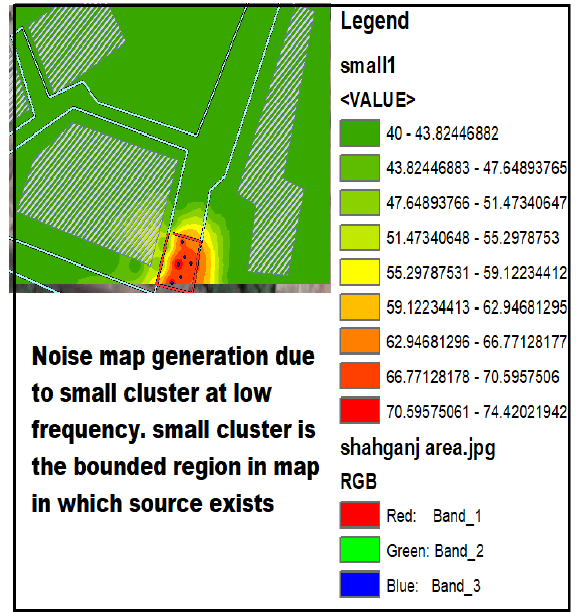
Figure 10. Noise map for the small cluster at low freq. 31.5